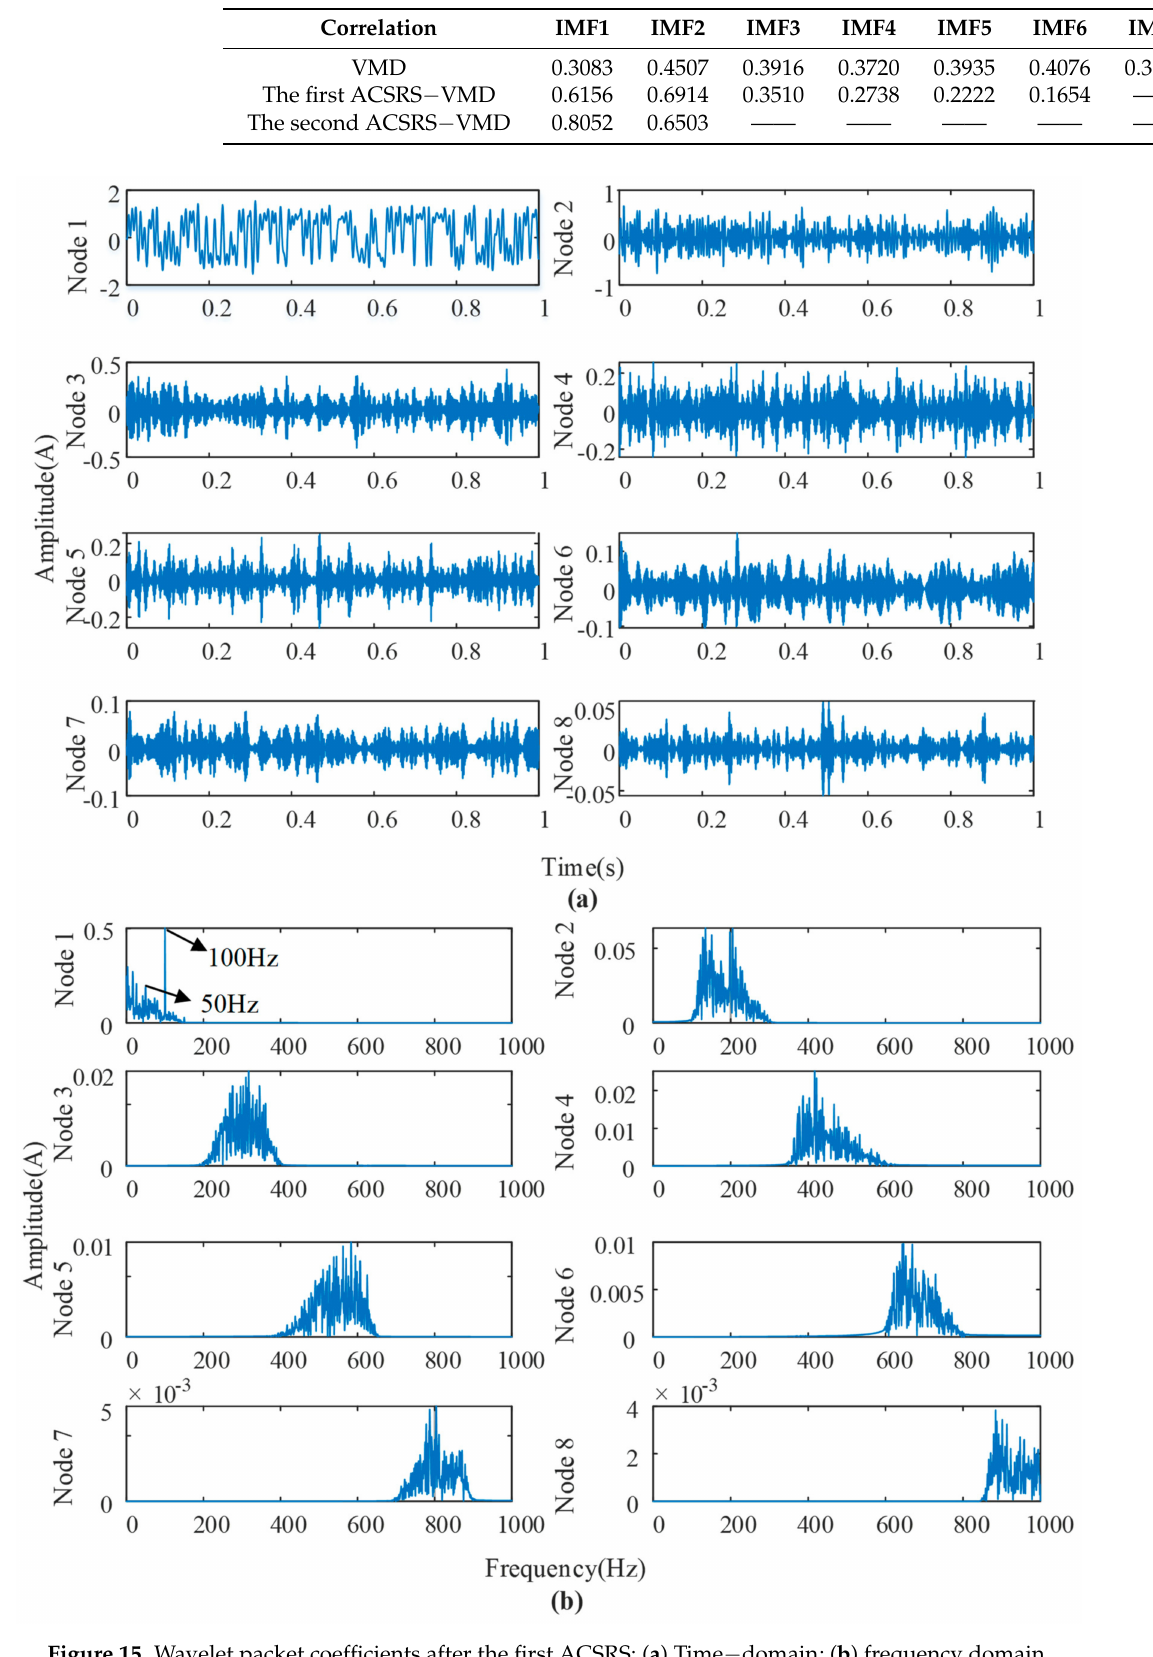
Figure 15. Wavelet packet coefficients after the first ACSRS: ( a ) Time − domain; ( b ) frequency